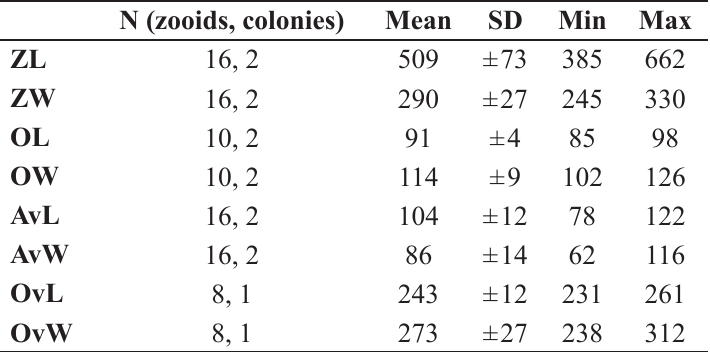
Table 1. Measurements in µm of Microporella bifoliata Ulrich & Bassler, 1904, Miocene, Choptank Formation, Maryland, USA; lectotype USNM 68592A, paralectotype USNM